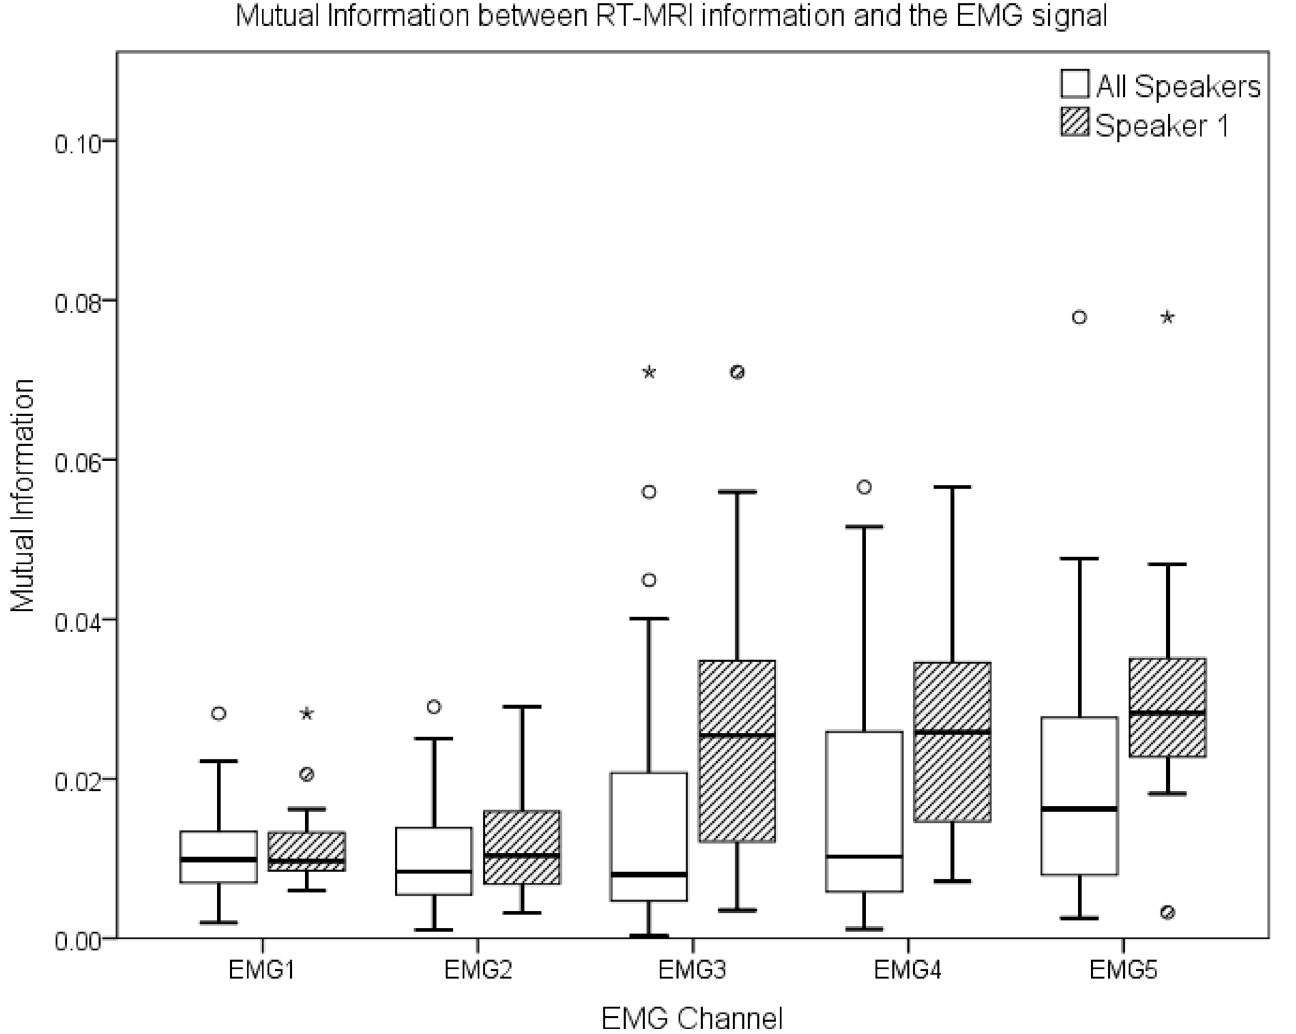
Fig 11. Boxplot of the mutual information in the nasal zones between the RT-MRI information and the EMG signal of all speakers and for a single